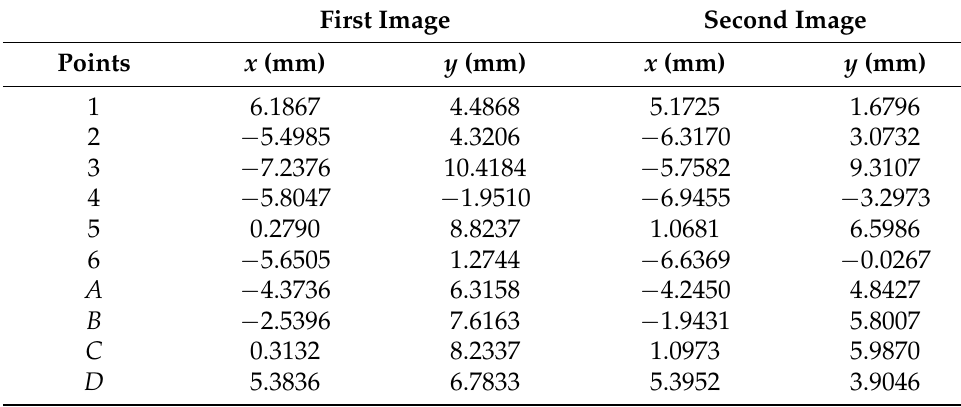
Table 3. Image plane coordinates of the two images of first experiment.